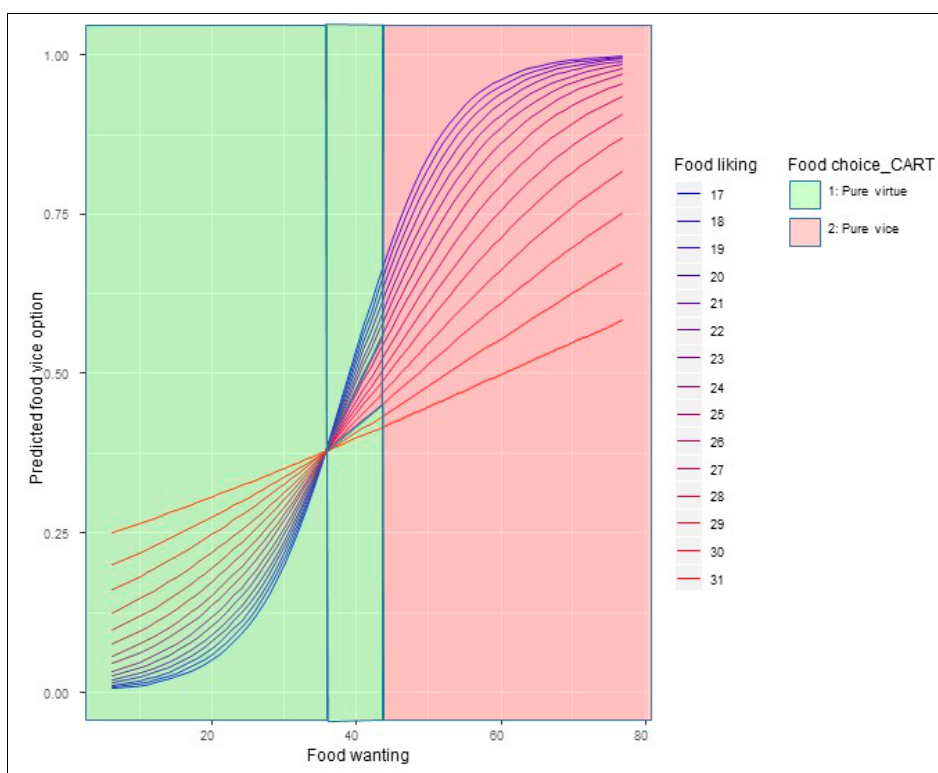
Figure 10. Marginal effects and Classification and Regression Tree (CART) of the interaction term (Food liking*Food wanting). Two-option set.